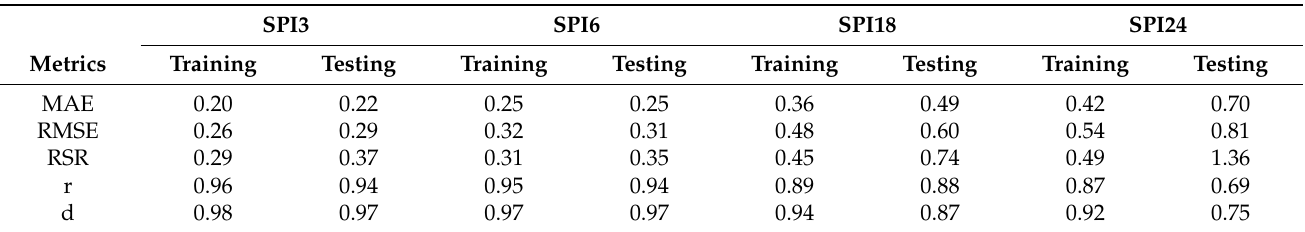
Table 4. Performance of proposed ANN-FA for drought modeling in 3 months, 6 months, 18 months, and 24 months (for both training and testing